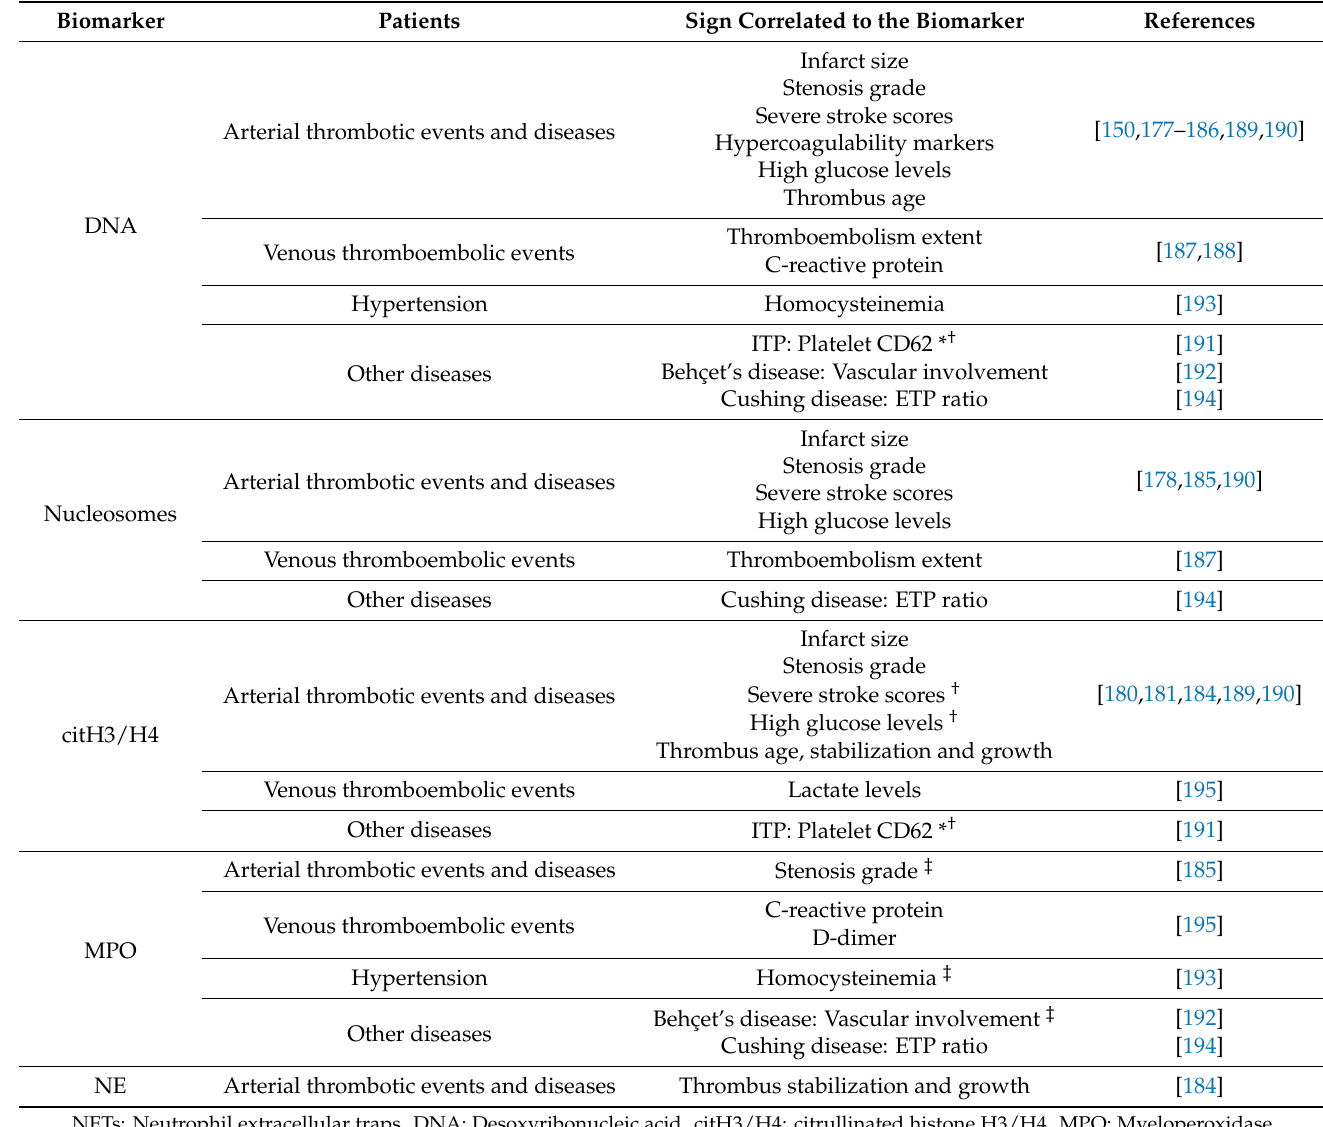
Table 3. NETs components detected in patients with different pathologies related to